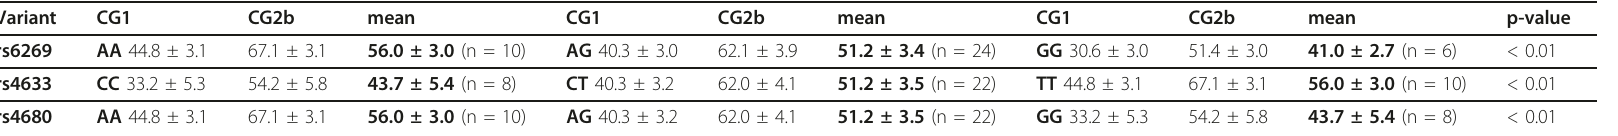
Table 1 S-COMT methylation [% ± SD] with respect to COMT genotype in Blood DNA (twin cohort)